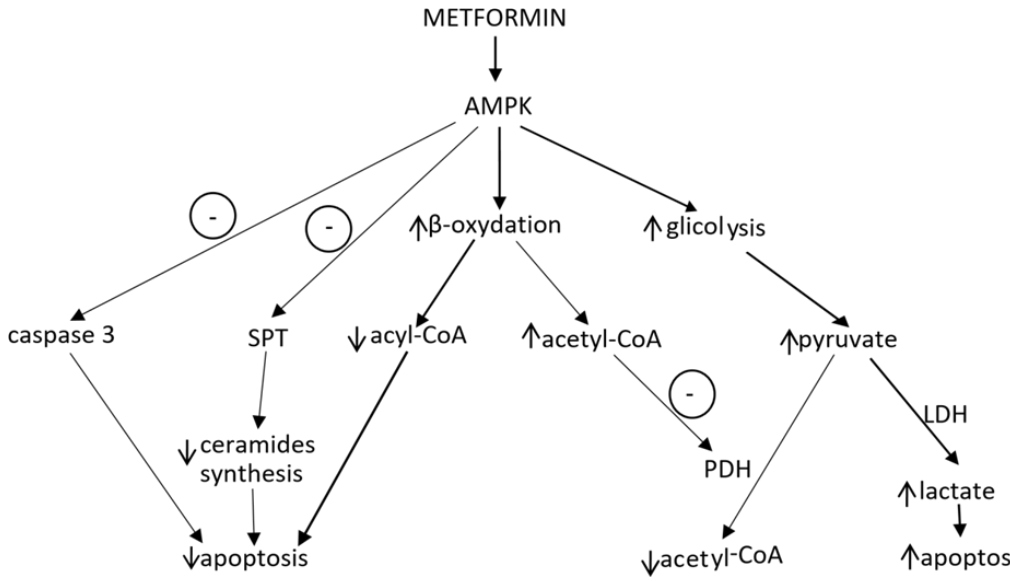
Figure 4. The effect of metformin on apoptosis. Acetyl-CoA, acetyl coenzyme A; acyl-CoA, acyl coenzyme A; AMPK, AMP-activated protein kinase; LDH, lactate dehydrogenase; PDH, pyruvate dehydrogenase; and SPT, serine palmitoyltransferase. ↑ and ↓ represent increase and decrease in the concentration of specific compound, respectively. Circles with “−” represent inhibitory effect.